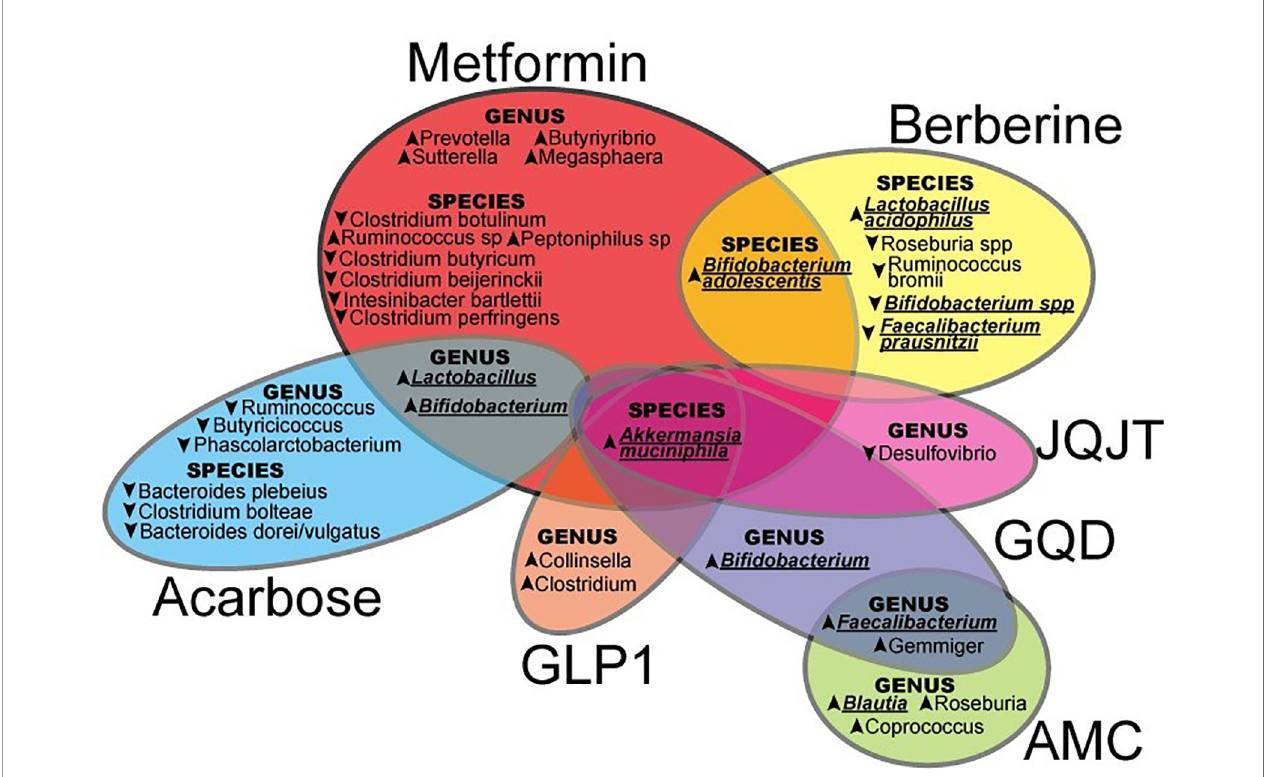
FIGURE 1 | The effects of Western Medicine and Traditional Chinese Medicine in shaping the gut microbiota which may contribute to the control and prevention of type 2 diabetes (JQJT, JinQi Jiangtang; GQD, Gegen Qinlian Decoction; AMC, speci fi cally designed herbal formula (no full name provided); GLP-1, Glucagon-like peptide-1.) In this review, summarized evidence suggested that both WM and TCM orchestrated different patterns on the microbiome, upward and downward arrows indicated an increase or decrease of certain microbiota by WM or TCM, and the particular microbiota underlined were possibly highlighted in the treatment of